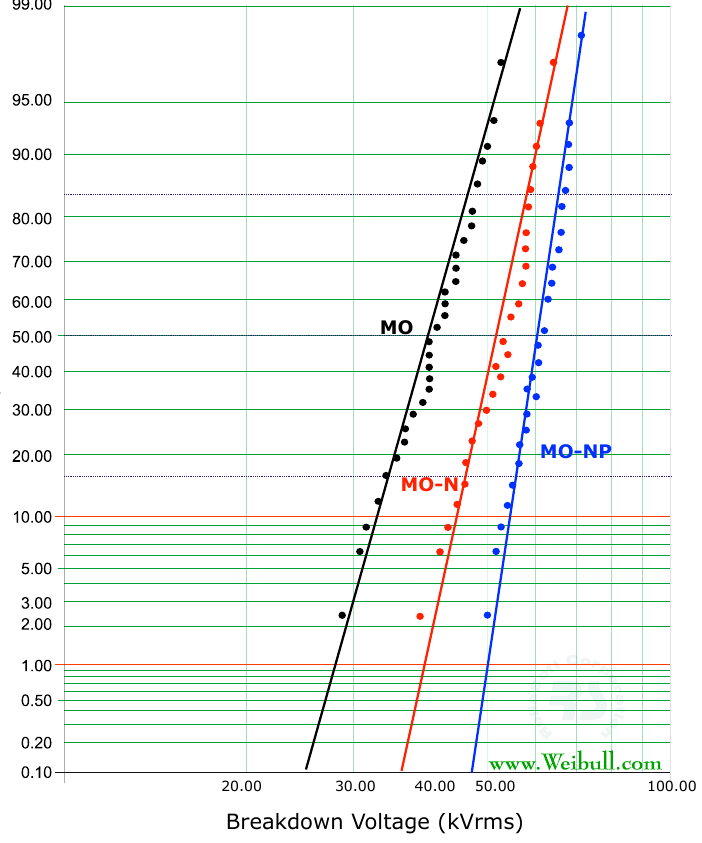
Figure 8. Comparison of the cumulative probability distribution of breakdown voltage in three oil samples.